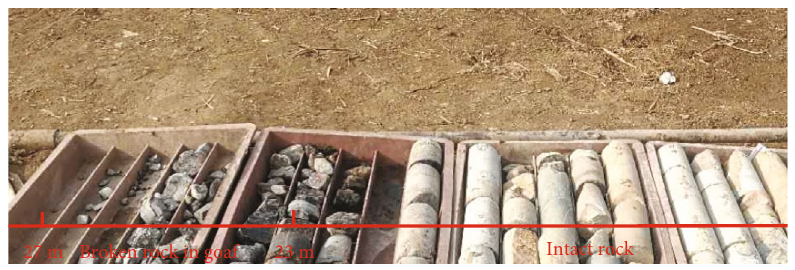
Figure 13: H-3 core before grouting